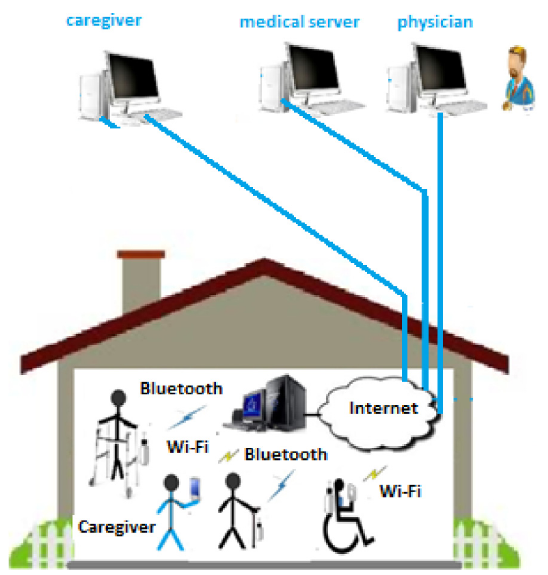
Figure 1. Diagram of patient-centred health monitoring for ‘ at home ’